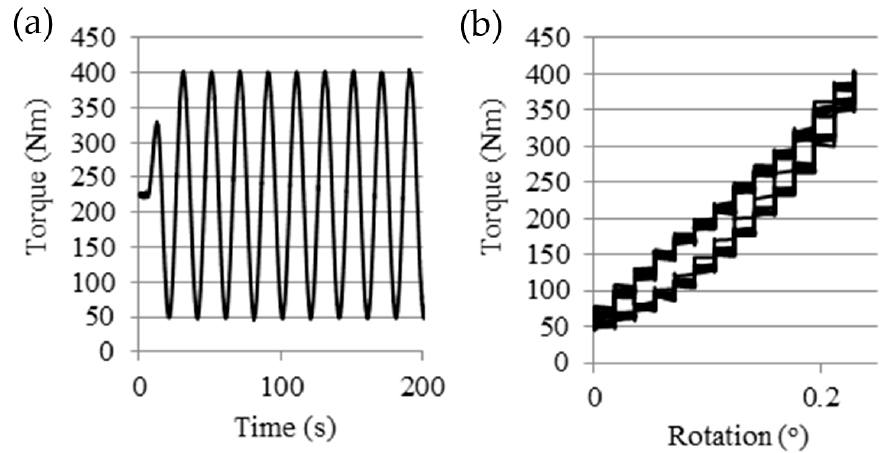
Figure 19. Cyclic loading—400 nm peak, 20 s period: ( a ) Torque versus time, ( b ) Torque versus rotation.